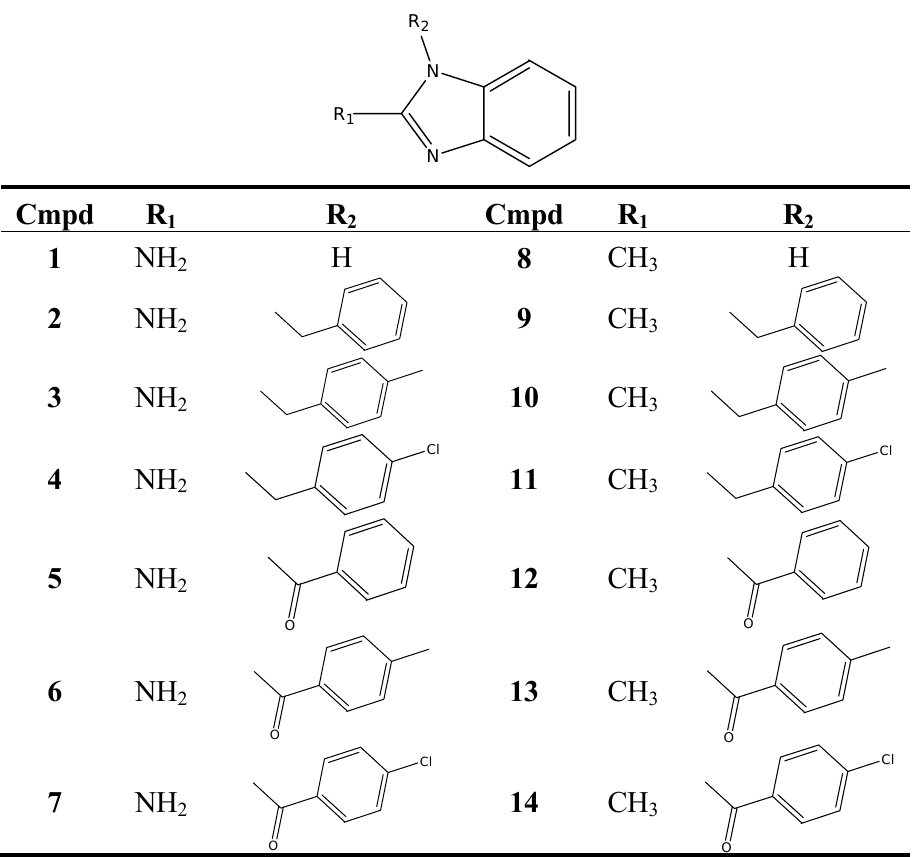
Table 1. The structures of the compounds studied.